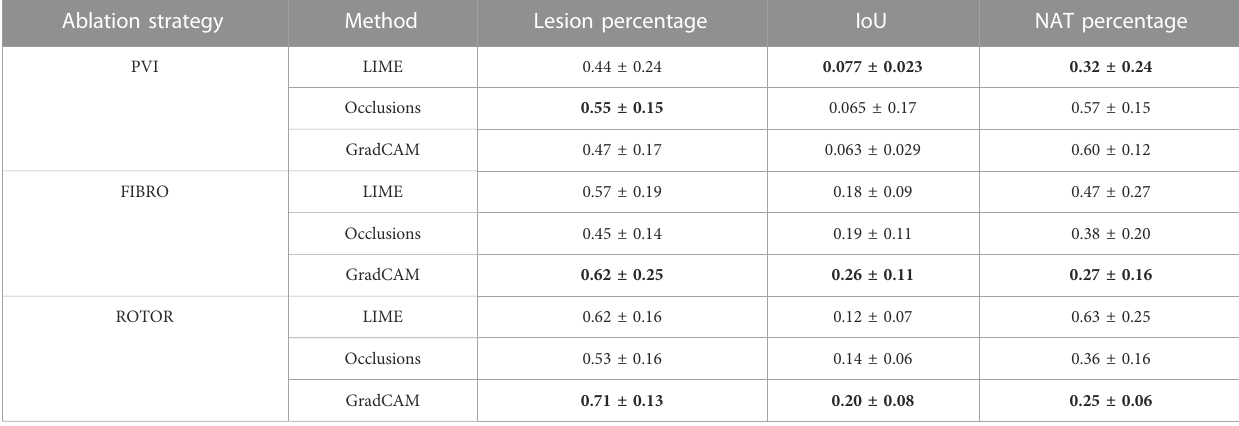
TABLE1Meanlesionpercentage,NATpercentage,IoUoftheinformativeregionandablationlesionswitherrors(standarddeviation)foreachFAmapmethodand RFCA strategy.